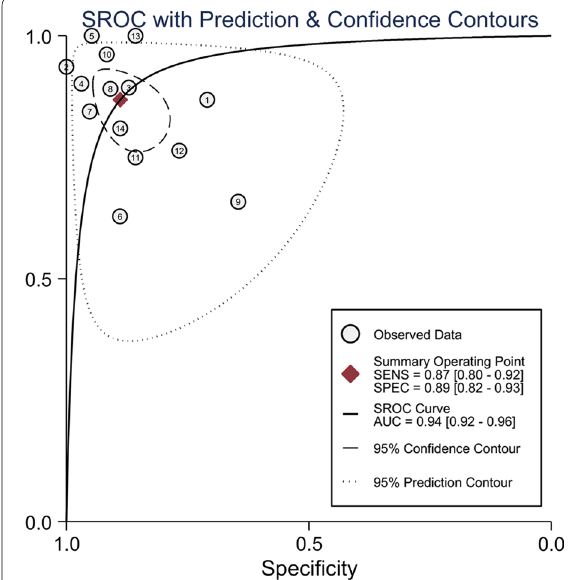
Fig. 3 Summary receiver operator characteristic (SROC) of CD64 across 14 included studies. Each circle indicates the estimate sensitivity and specificity of each study. AUC area under curve, SENS sensitivity, SPEC specificity